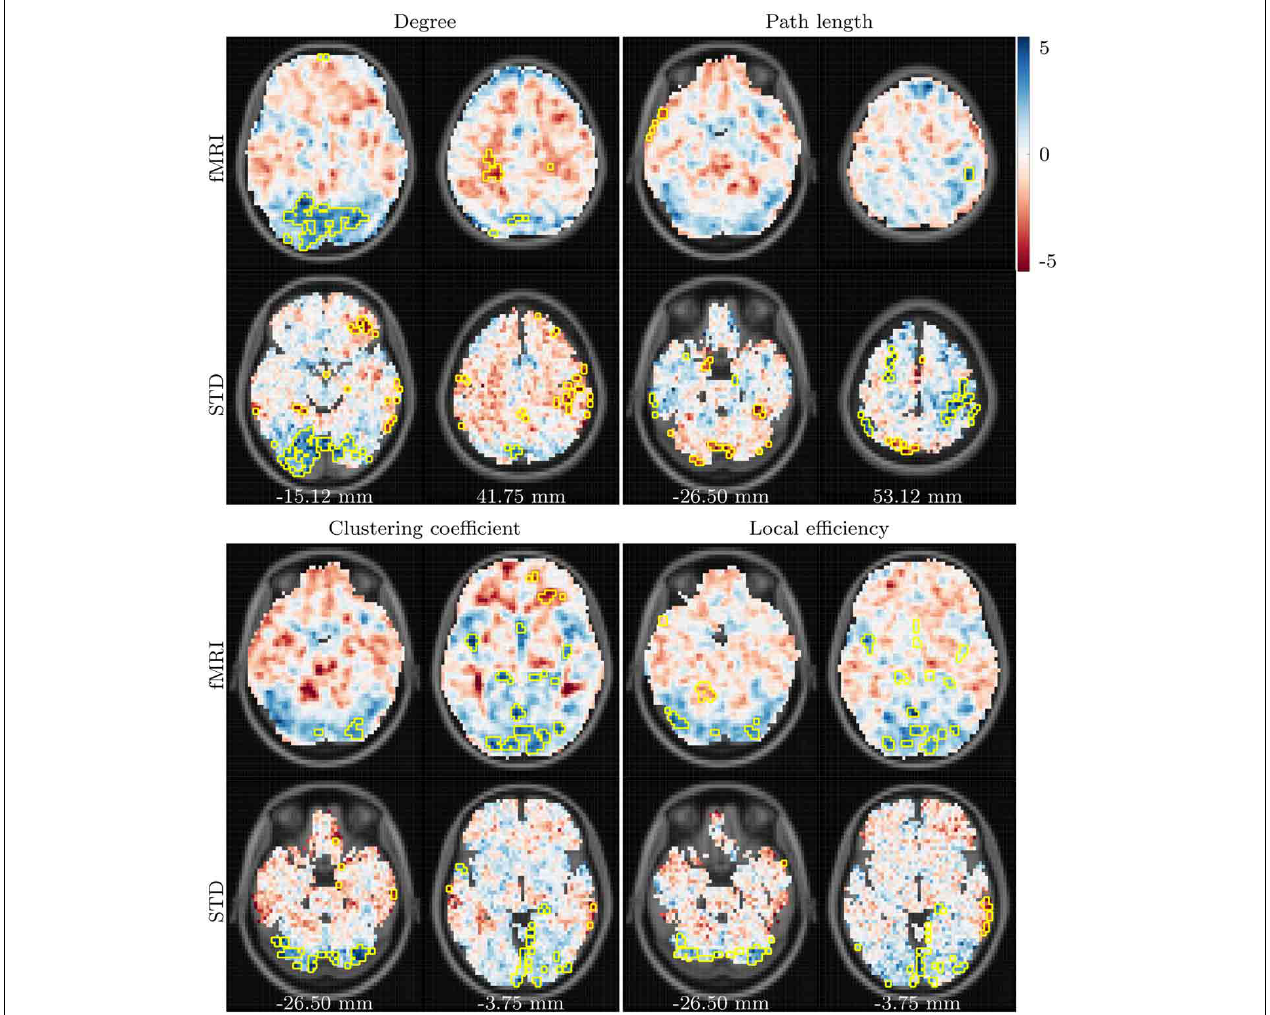
FIGURE 2 | t -values showing differences between the young and aged groups in fMRI and standard space task based networks. Data for degree, path length and clustering coefficient are shown for correlation threshold 0.82, and data for local efficiency shown for correlation threshold 0.96. Voxels found to be significantly different for at least two correlation thresholds are highlighted with a yellow border. Anterior is